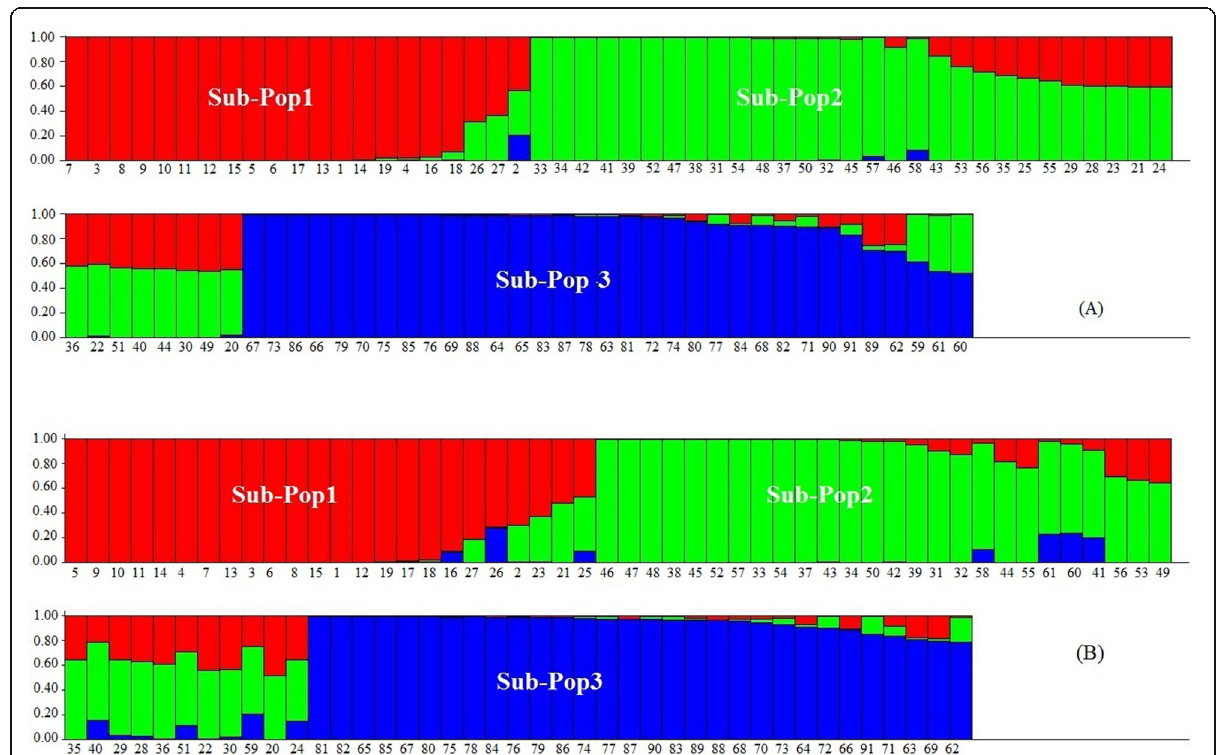
Fig. 3 Population structure of 91 Triticum and Aegilops accessions using SCoT (panel a ) and CBDP (panel b